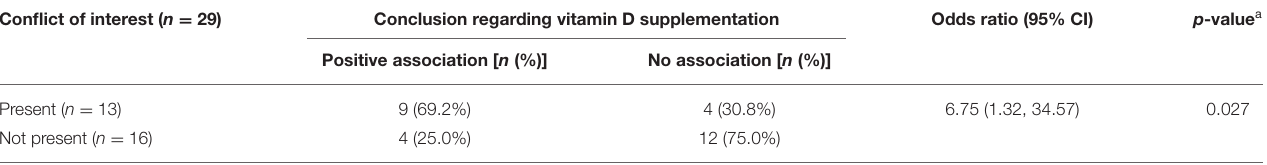
TABLE 3 | Distribution of conclusions regarding vitamin D and COVID-19 prevention or treatment, according to conflict of interest. Conflict of interest ( n =